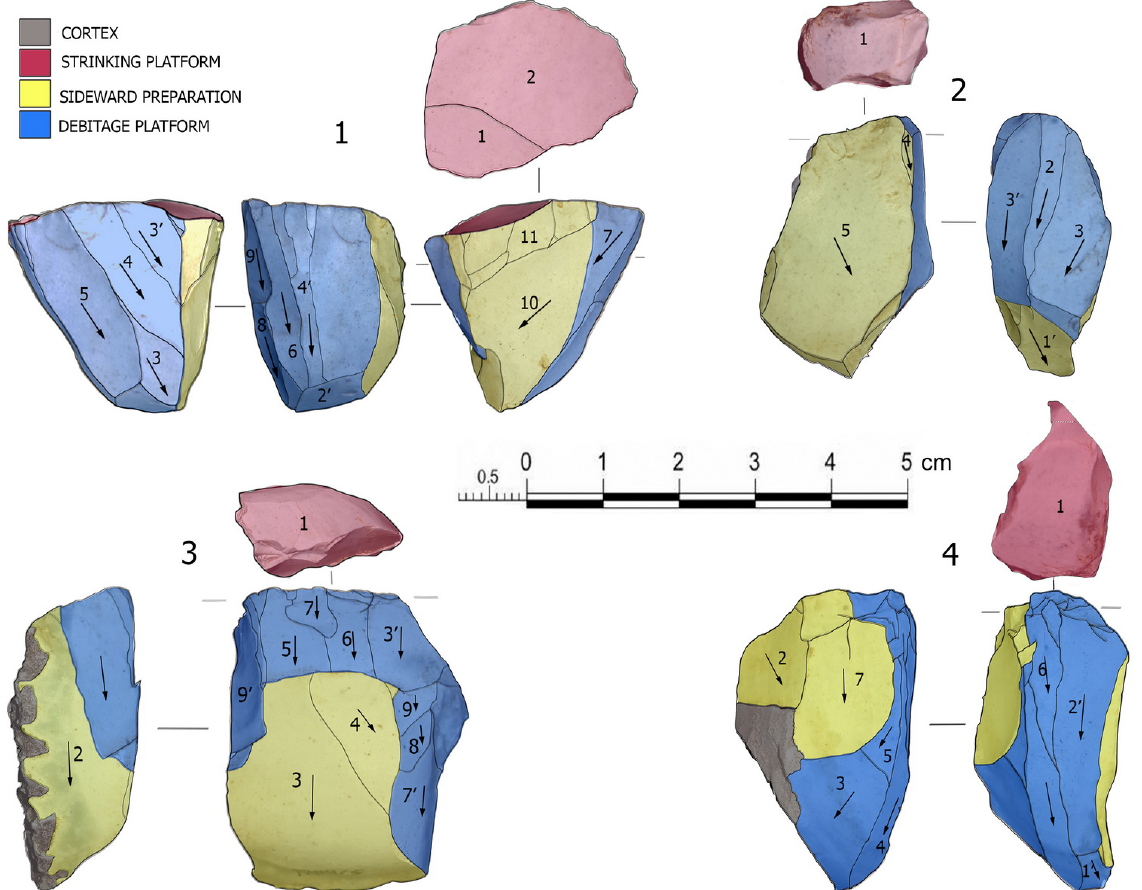
Figure 17. Assemblage of cores from Tajo de Marchales. 1, 2 and 4) Unipolar cores with plain frontal progression, 3) Frontal progression core.